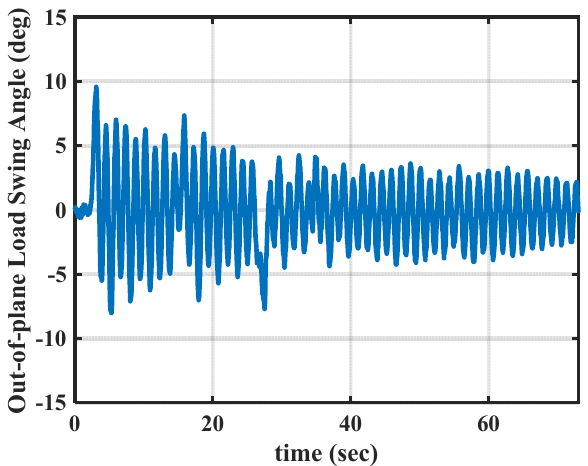
Figure 14. Out–of–plane load swing angles θ L (as described in Figure 4).